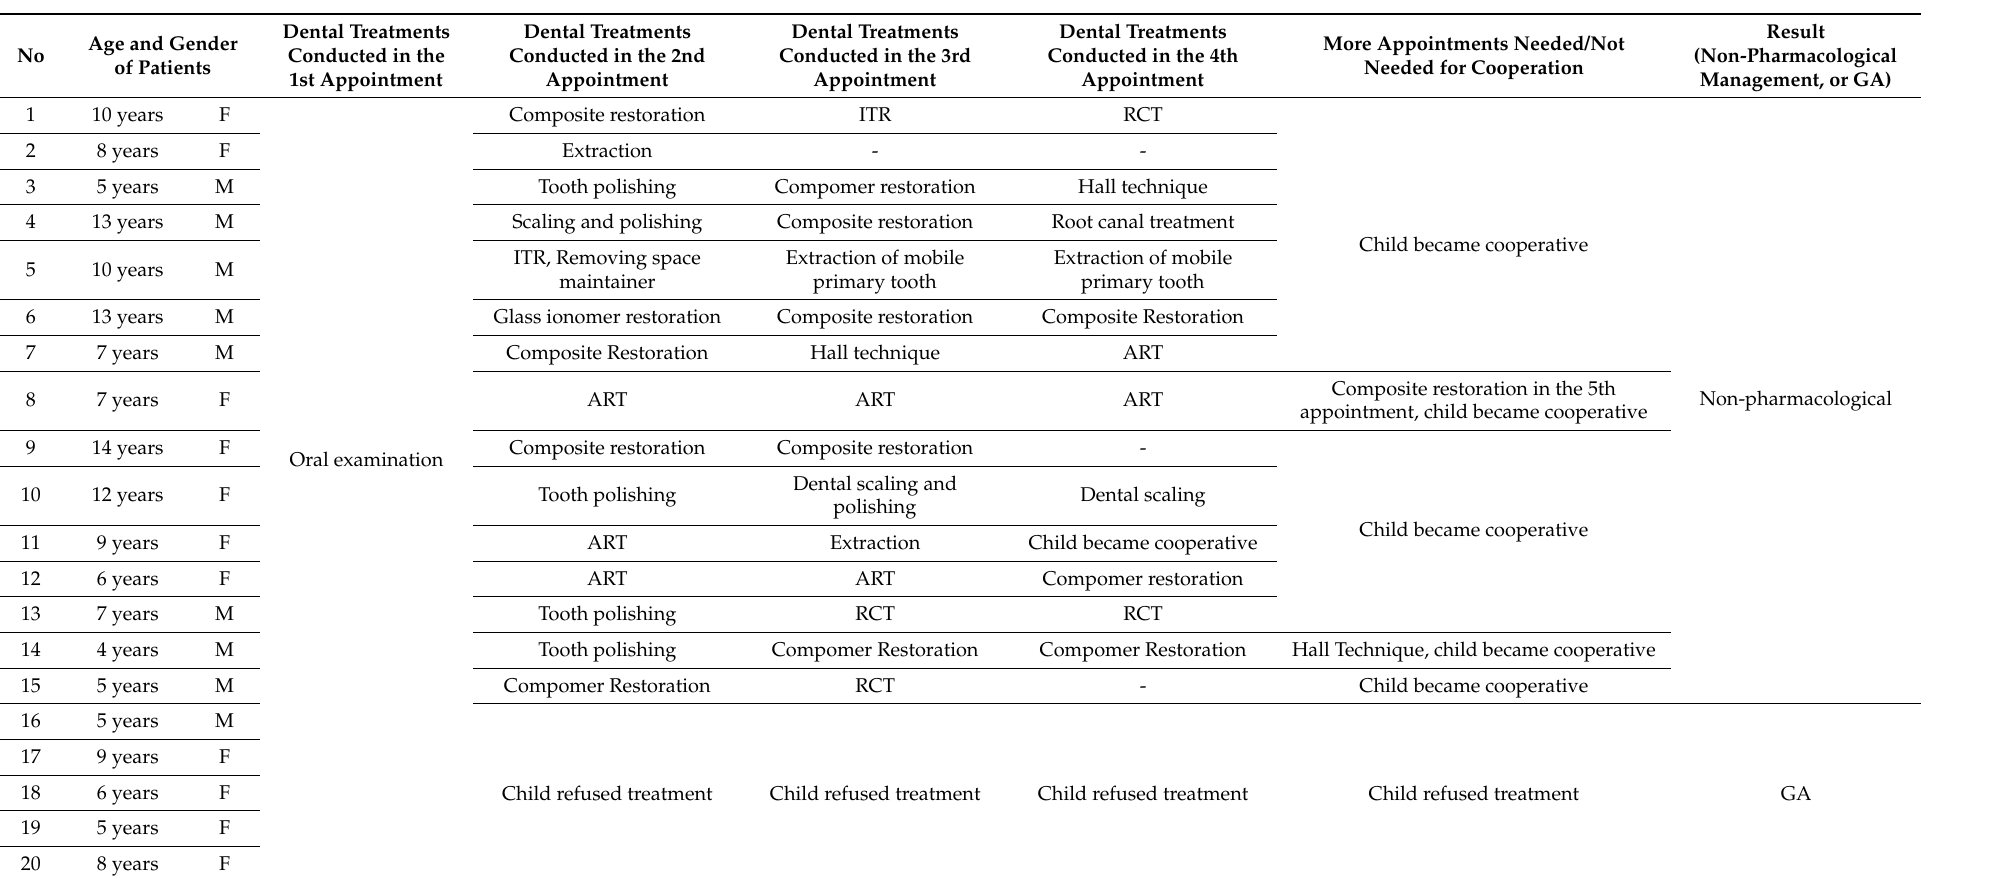
Table 6. The number of appointments and the dental treatments conducted at each appointment until the children cooperated in the treatment group. Dental Treatments Age and Gender Conducted in No of Patients